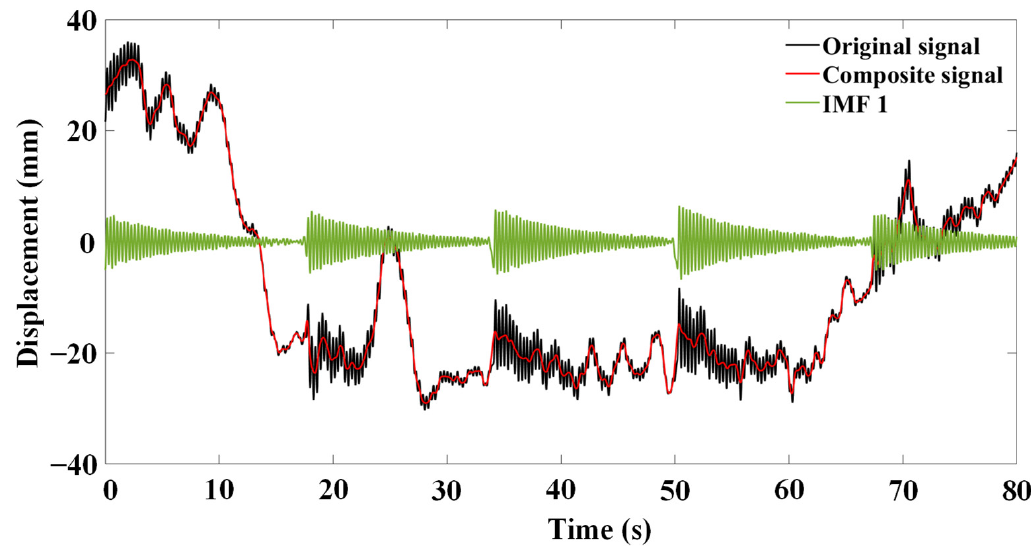
Figure 13. Original signal, IMF 1 and composite signal. Table 1. Indexes of three methods.